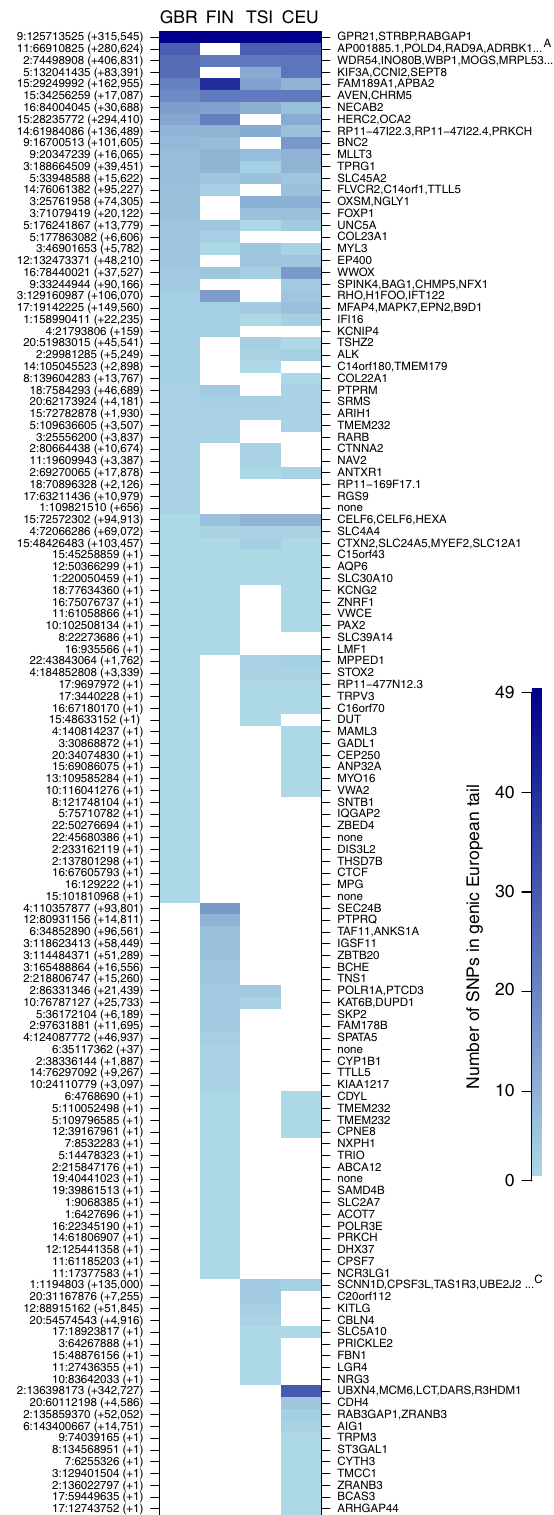
Figure 5 | Genic alleles in the DAnc(YRI, Europe, UI) tail and overlapping genes. Close-by alleles are combined in a region if they are o 100-kb apart. The left side of the figure shows the chromosomal position (chr:start) and the length in bp of each region. The right side shows the genes that overlap with each region. The number of alleles in each genic DAnc tail ( P 2 : GBR, FIN, TSI, CEU) is shown with the heatmap. Columns are ordered by number of alleles starting left. Superscripts note regions with too many genes to fit the figure: A : ANKRD13D, SSH3, CLCF1, PPP1CA, TBC1D10C, CARNS1, KDM2A; B : CCDC142, PCGF1, DQX1, AUP1, DCTN1, C2orf81, RTKN, LBX2, TLX2, HTRA2, LOXL3, DOK1, SEMA4F, TTC31, M1AP, RP11-287D1.3, SLC4A5; C : ACAP3, PUSL1, GLTPD1, DVL1, MXRA8, CCNL2,